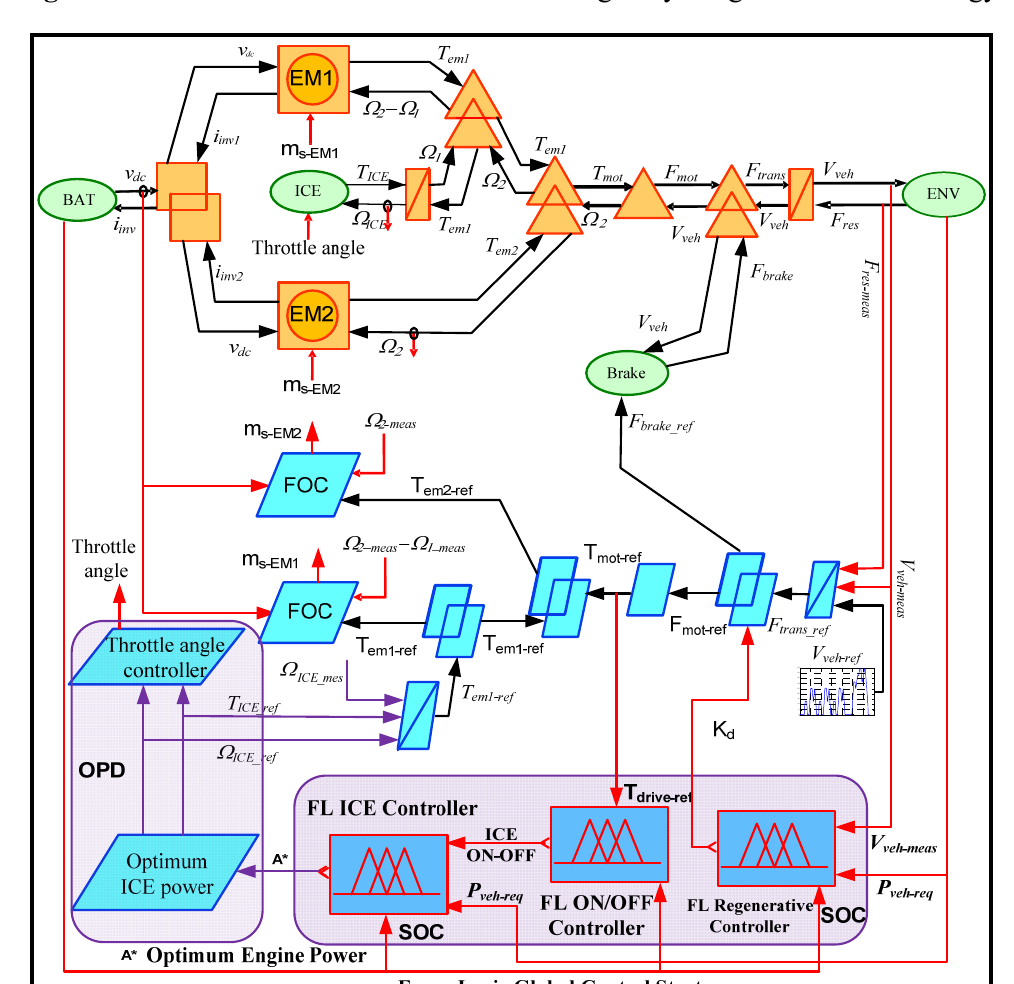
Figure 9. The EMR of PMSM-EVT-HEV managed by FL global control